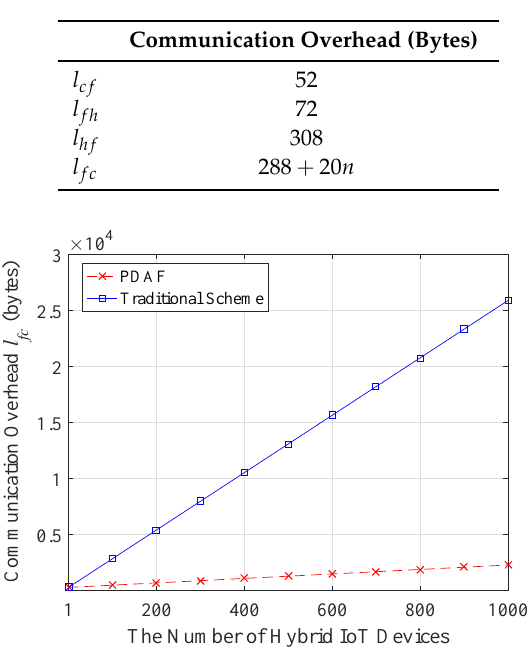
Figure 4. The communication overhead